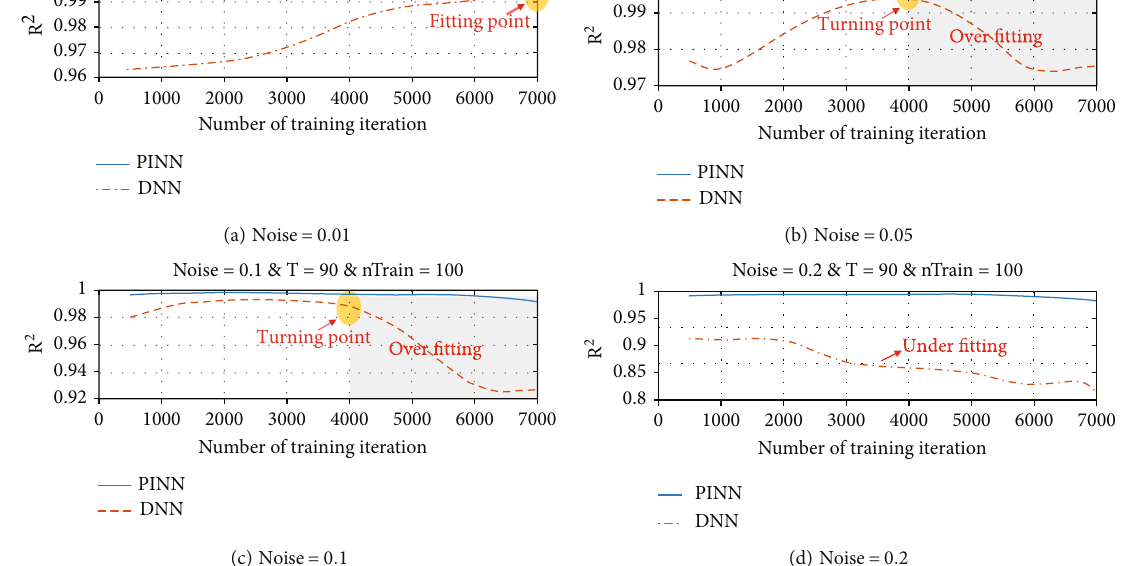
Figure 7: The e ff ect of noise corruption levels.